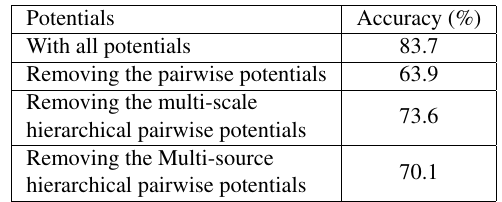
Table 5: The performance comparison when dropping one types of potentials in the MSMSH-CRF